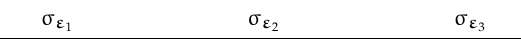
Table 6. In units of π a 2